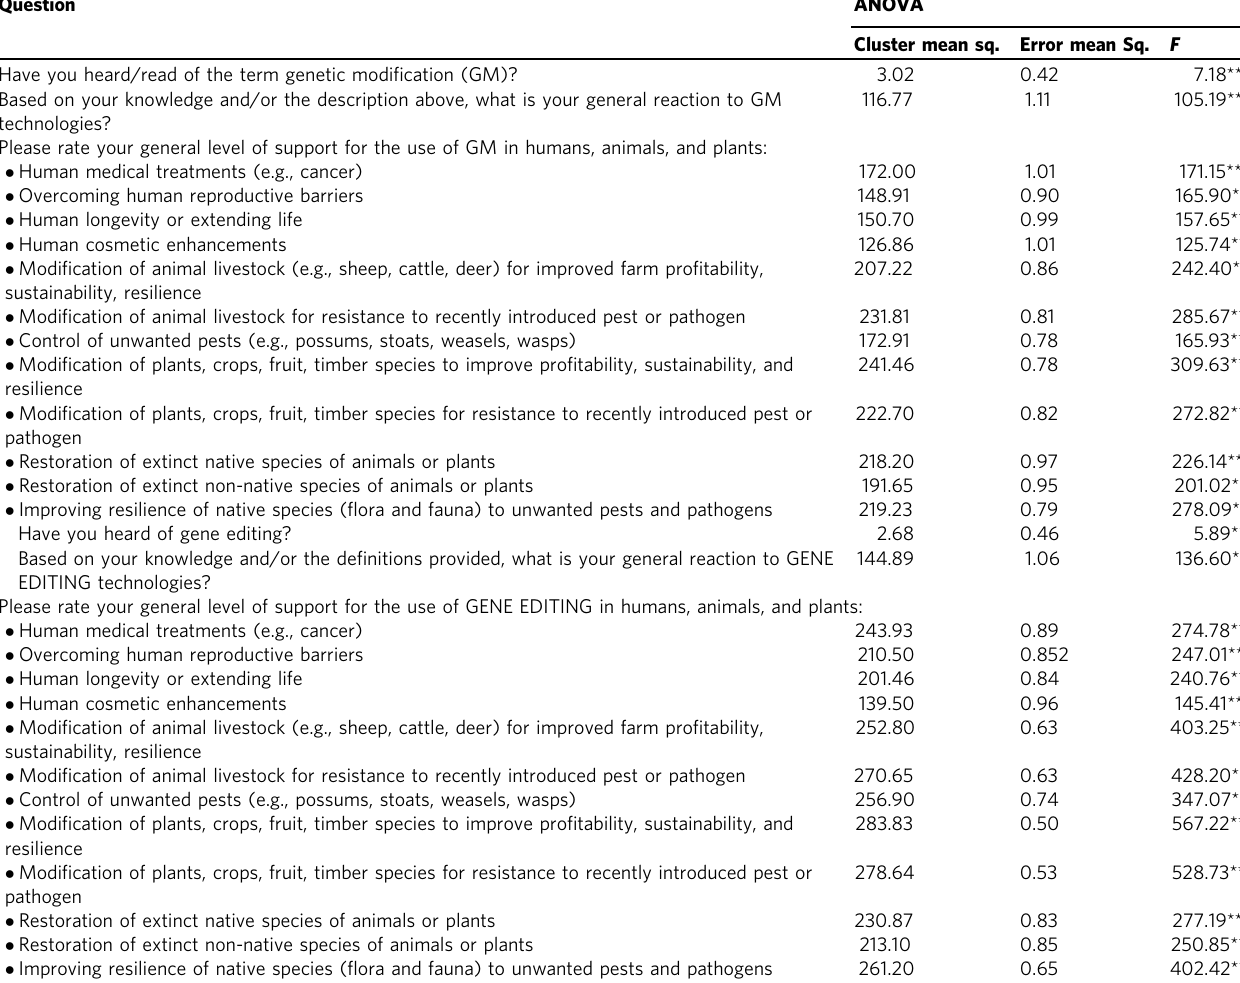
Table 1 Variables used in the cluster analysis and ANOVA